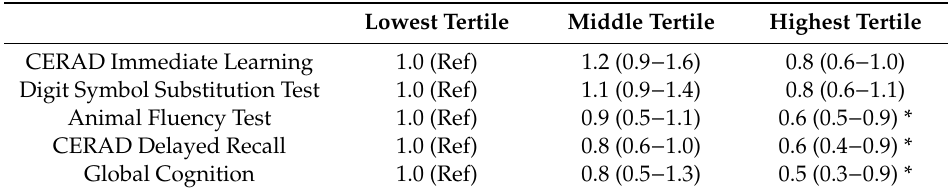
Table 5. Survey-weighted odds ratios (95% confidence intervals) for low cognitive performance across tertiles of MedD adherence ( n =